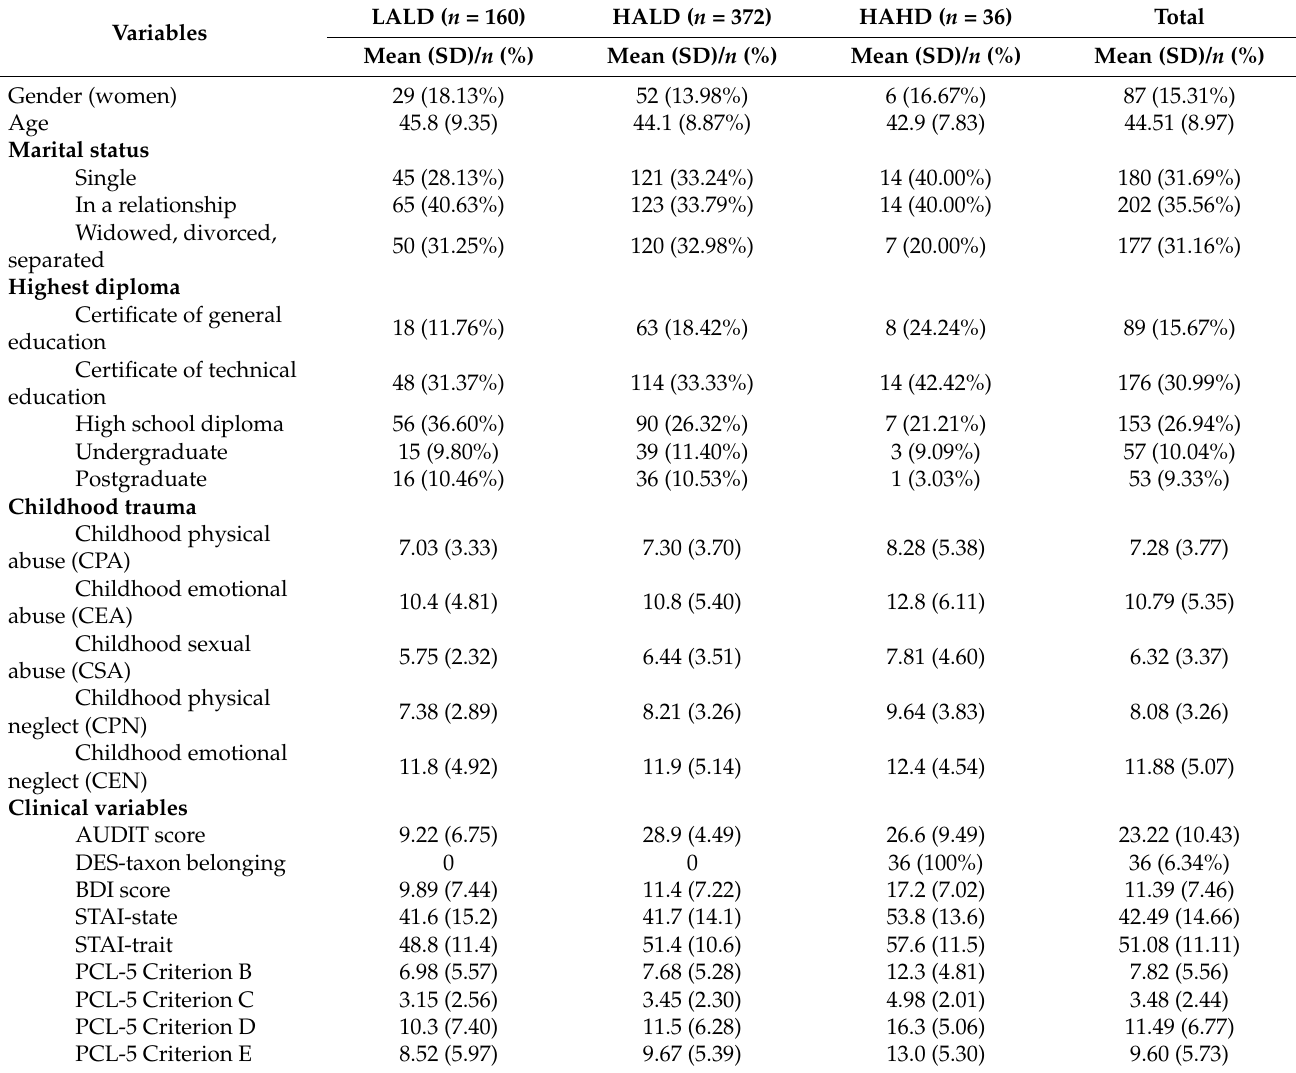
Table 1. Sociodemographic and clinical characteristics of the participants by